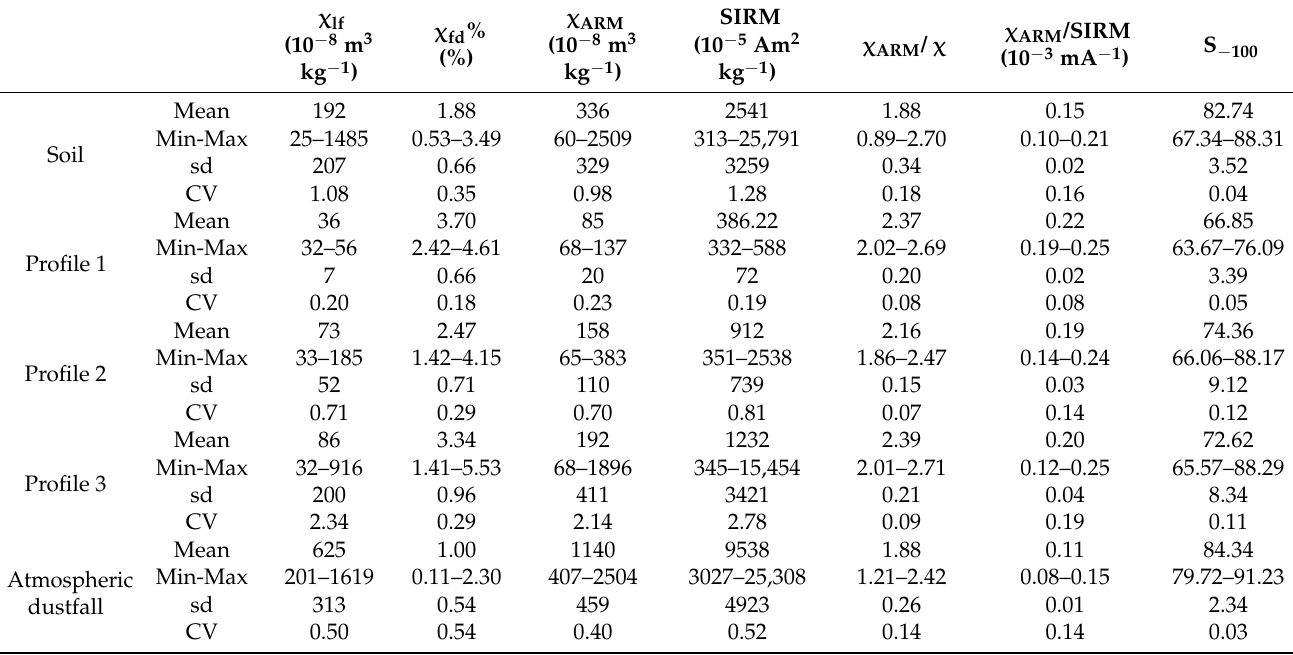
Table 1. Summary of the magnetic parameters of topsoil, soil profiles and atmospheric dustfall from Baiyin city.